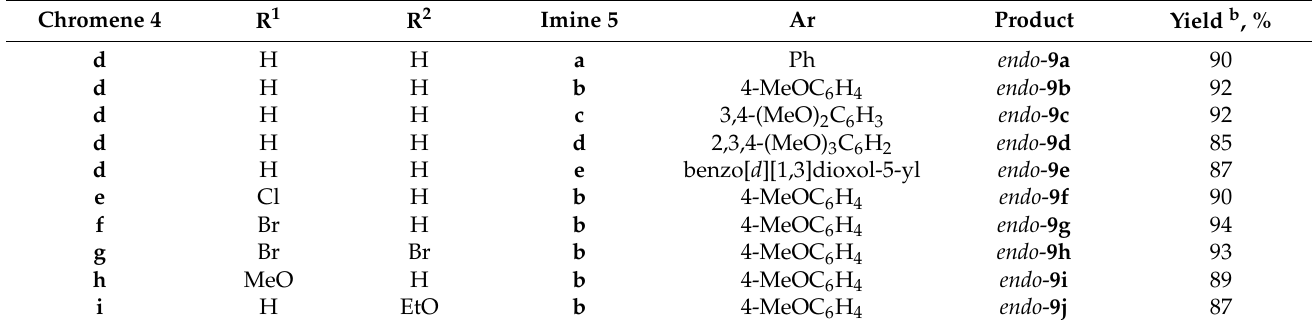
Table 3. Scope of the synthesis of 4-CF 3 -substituted chromeno[3,4- c ]pyrrolidines 9 a .